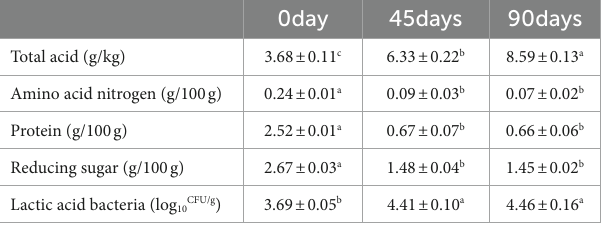
TABLE 1 Changes in physicochemical properties and lactic acid bacteria growth of LSCKs fermented for 0, 45, and 90